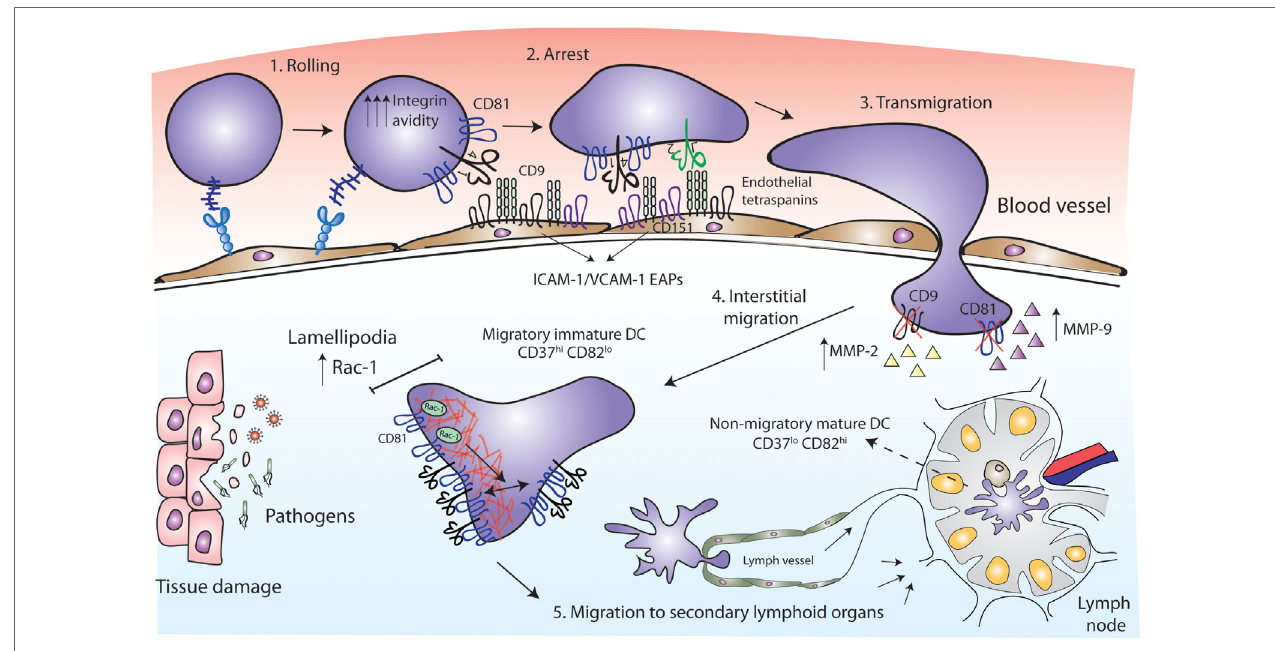
FigURe 2 | Tetraspanins act as key players in antigen-presenting cell (APC) migration. CD81 facilitates rolling and arrest under shear flow, increasing the avidity of VLA-4 integrin. Tetraspanins CD9 and CD151 congregate the endothelial adhesion receptors (ICAM-1 and VCAM-1) in clusters called endothelial adhesive platforms, thus controlling their adhesive properties and leukocyte extravasation. CD9 and CD81 deficiency results in an increase of MMP-2 and MMP-9 metalloproteinases production and activity, required for interstitial migration. Once in the tissue, CD81 tetraspanin controls cell migration via Rac-1-dependent mobilization of preformed integrin clusters at the leading edge and contributes to the formation of lamellipodia. While migratory immature dendritic cells (DCs) are CD37 hi and CD82 lo , mature DCs at the lymph nodes are CD37 lo CD82 hi , and display reduced migratory capacity and efficient antigen presentation